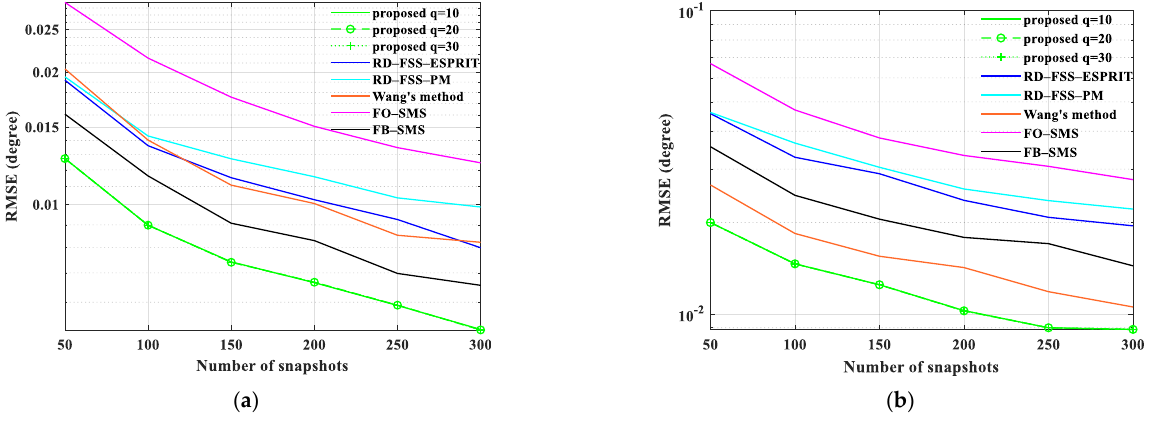
Figure 6. RMSE versus snapshots (pulses). ( a ) Scenario 1: three coherent targets are located at θ k = 10 ◦ ,20 ◦ ,30 ◦ , SNR = 10 dB; ( b ) Scenario 2: θ k = 45 ◦ ,55 ◦ ,65 ◦ , SNR = 20